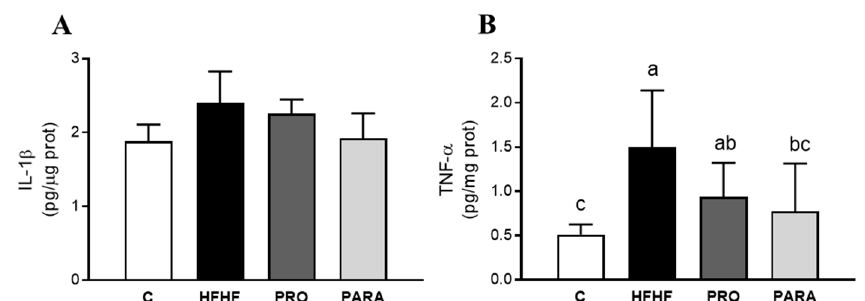
Figure 2. Hepatic levels of IL-1ß ( A ) and TNF- α ( B ) in rats fed a control diet (C), a high-fat high- fructose diet (HFHF) or a high-fat high-fructose diet supplemented with viable or heat-inactivated 10 9 CFU/day of Lactobacillus rhamnosus GG (PRO and PARA, respectively). Values are presented as mean ± SEM. Differences among the groups were determined by using one-way ANOVA, followed by the Newman–Keuls post hoc test. Bars not sharing common letters are significantly different ( p < 0.05). IL-1ß: interleukin 1ß, TNF- α : tumor necrosis factor α .